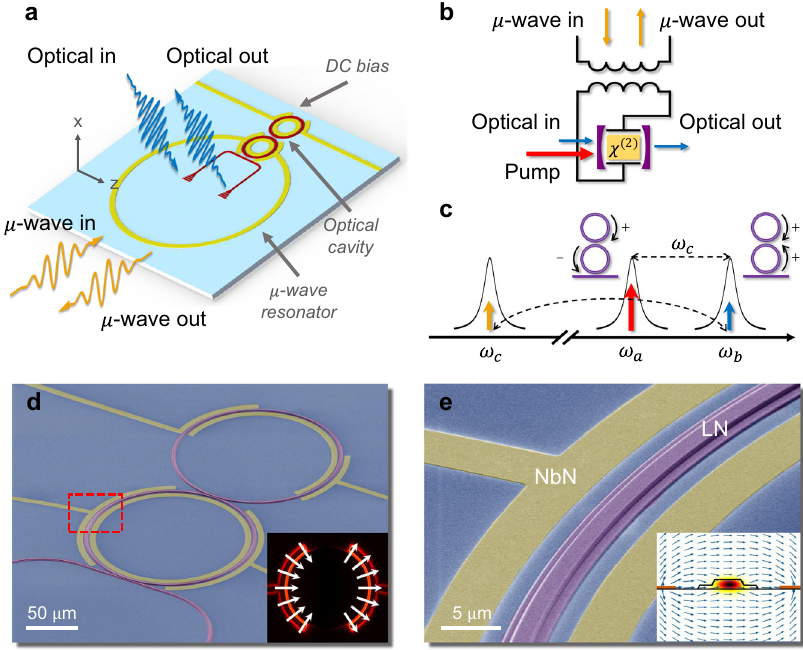
Fig. 1 Superconducting cavity electro-optics system and device design. a Schematic layout of the TFLN EO converter, where two strongly coupled microring resonators (red) are co-integrated with a planar superconducting resonator (yellow). DC electrodes are utilized for on-chip tuning of the optical modes. b Circuit representation of the cavity EO system. The capacitor plate of the lumped-element microwave resonator is coupled to the χ (2) optical cavity. c Three wave-mixing EO conversion process. The optical doublet corresponds to the symmetric and anti-symmetric supermodes of the coupled microrings. A strong pump (red) at the anti-symmetric mode frequency parametrically stimulates the bidirectional conversion between signal photons in the symmetric mode (blue) and the microwave mode (yellow). d , e False-color scanning electron microscope images of the EO converter device. Insets show the electric fi eld pro fi les of interacting optical and microwave modes.